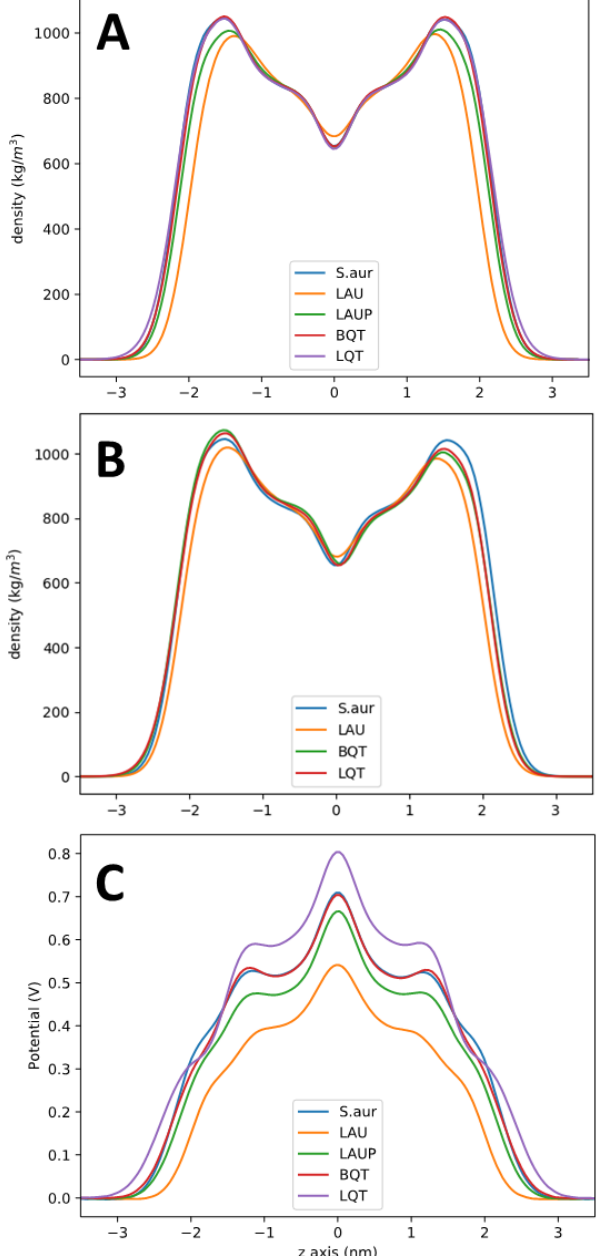
Figure 3. ( A ) . Partial density profile for pure S. aureus , and with LAU, LAUP, LQT, and BQT. The density is for all the lipids and small molecules in the system. ( B ) . Partial density profiles for the asymmetric membrane systems. ( C ) . Electrostatic potential across each